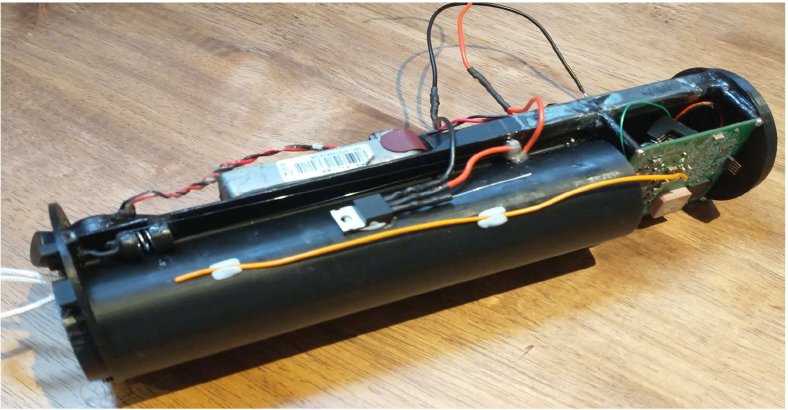
Figure 20. Component carrier, with MOSFET, SMA wires and pinpuller visible at top, ThumbSat at lower right, ¼ wavelength monopole antenna (yellow) in the centre.